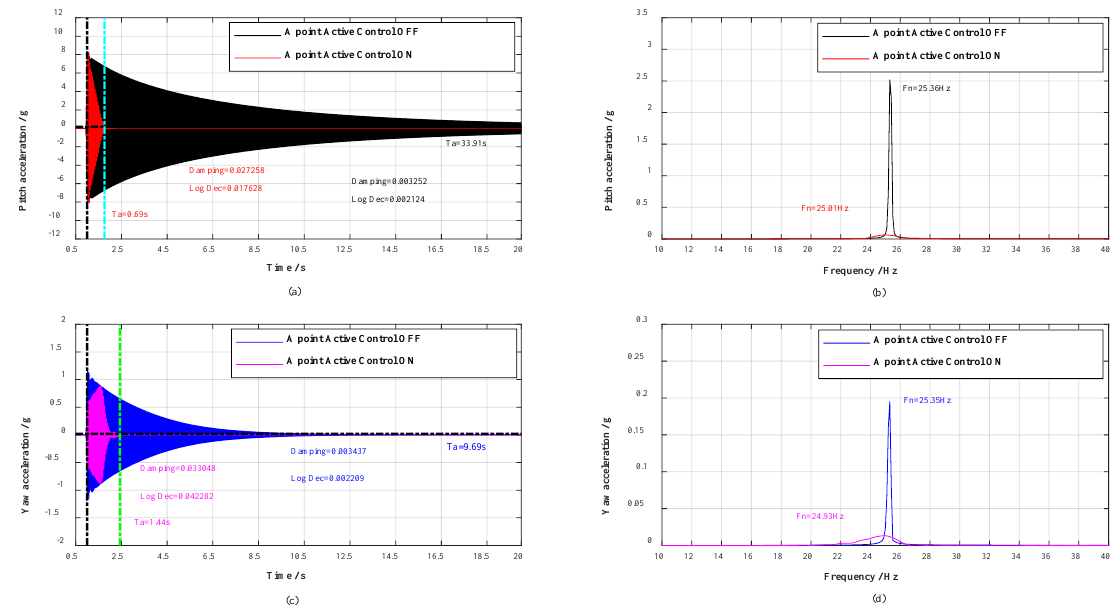
Figure 6. Response spectral analysis. Control effect during impulse tests in pitch plane (A point).